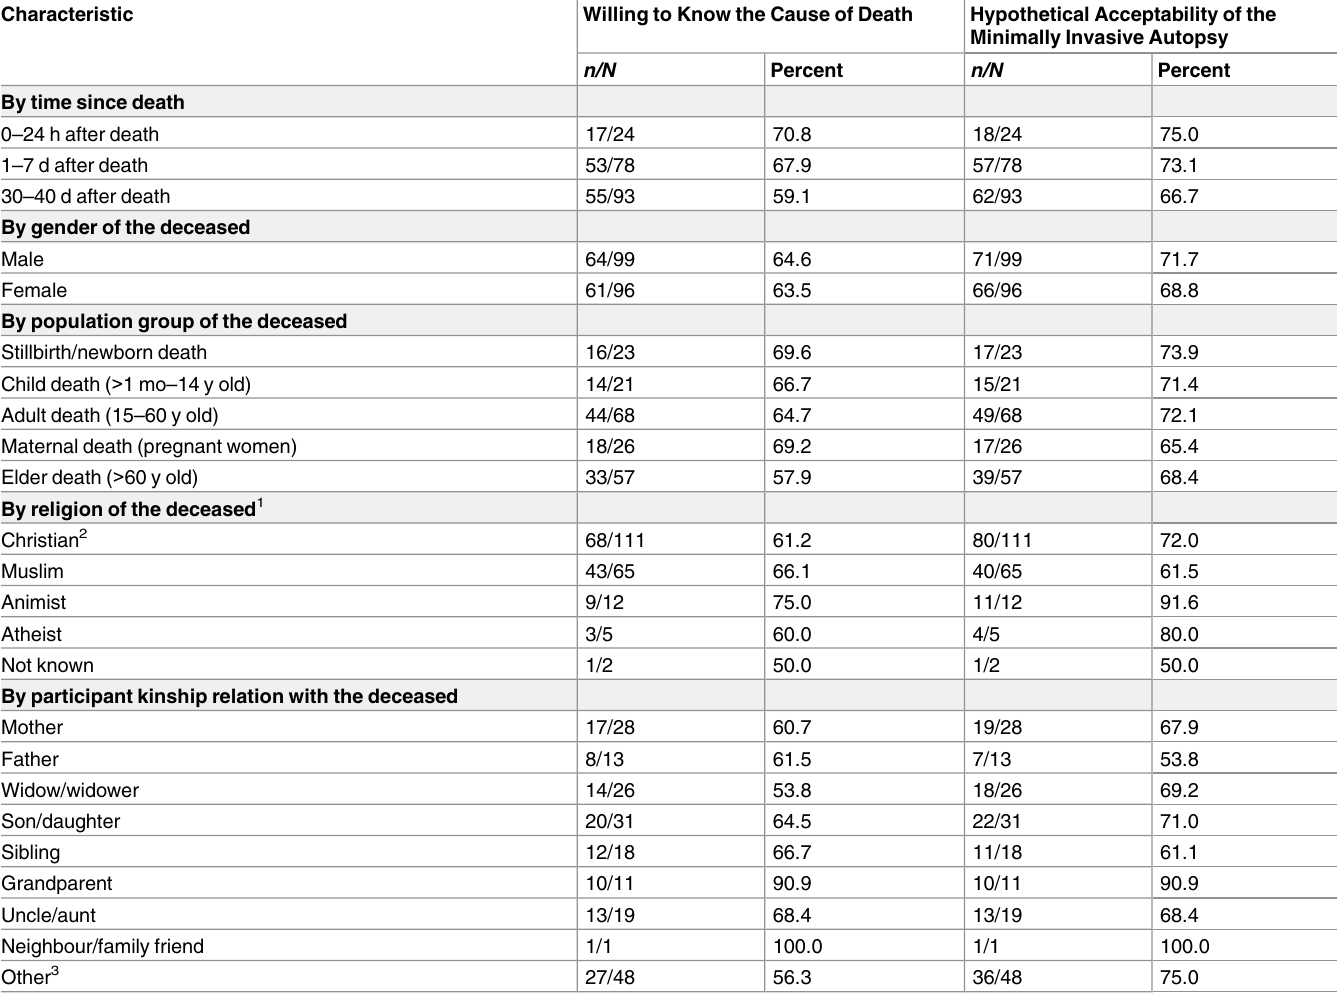
Table 4. Willingness to know the cause of death and hypothetical acceptability of the minimally invasive autopsy among relatives of deceased people, by socio-demographic characteristics of the deceased and kinship relation.